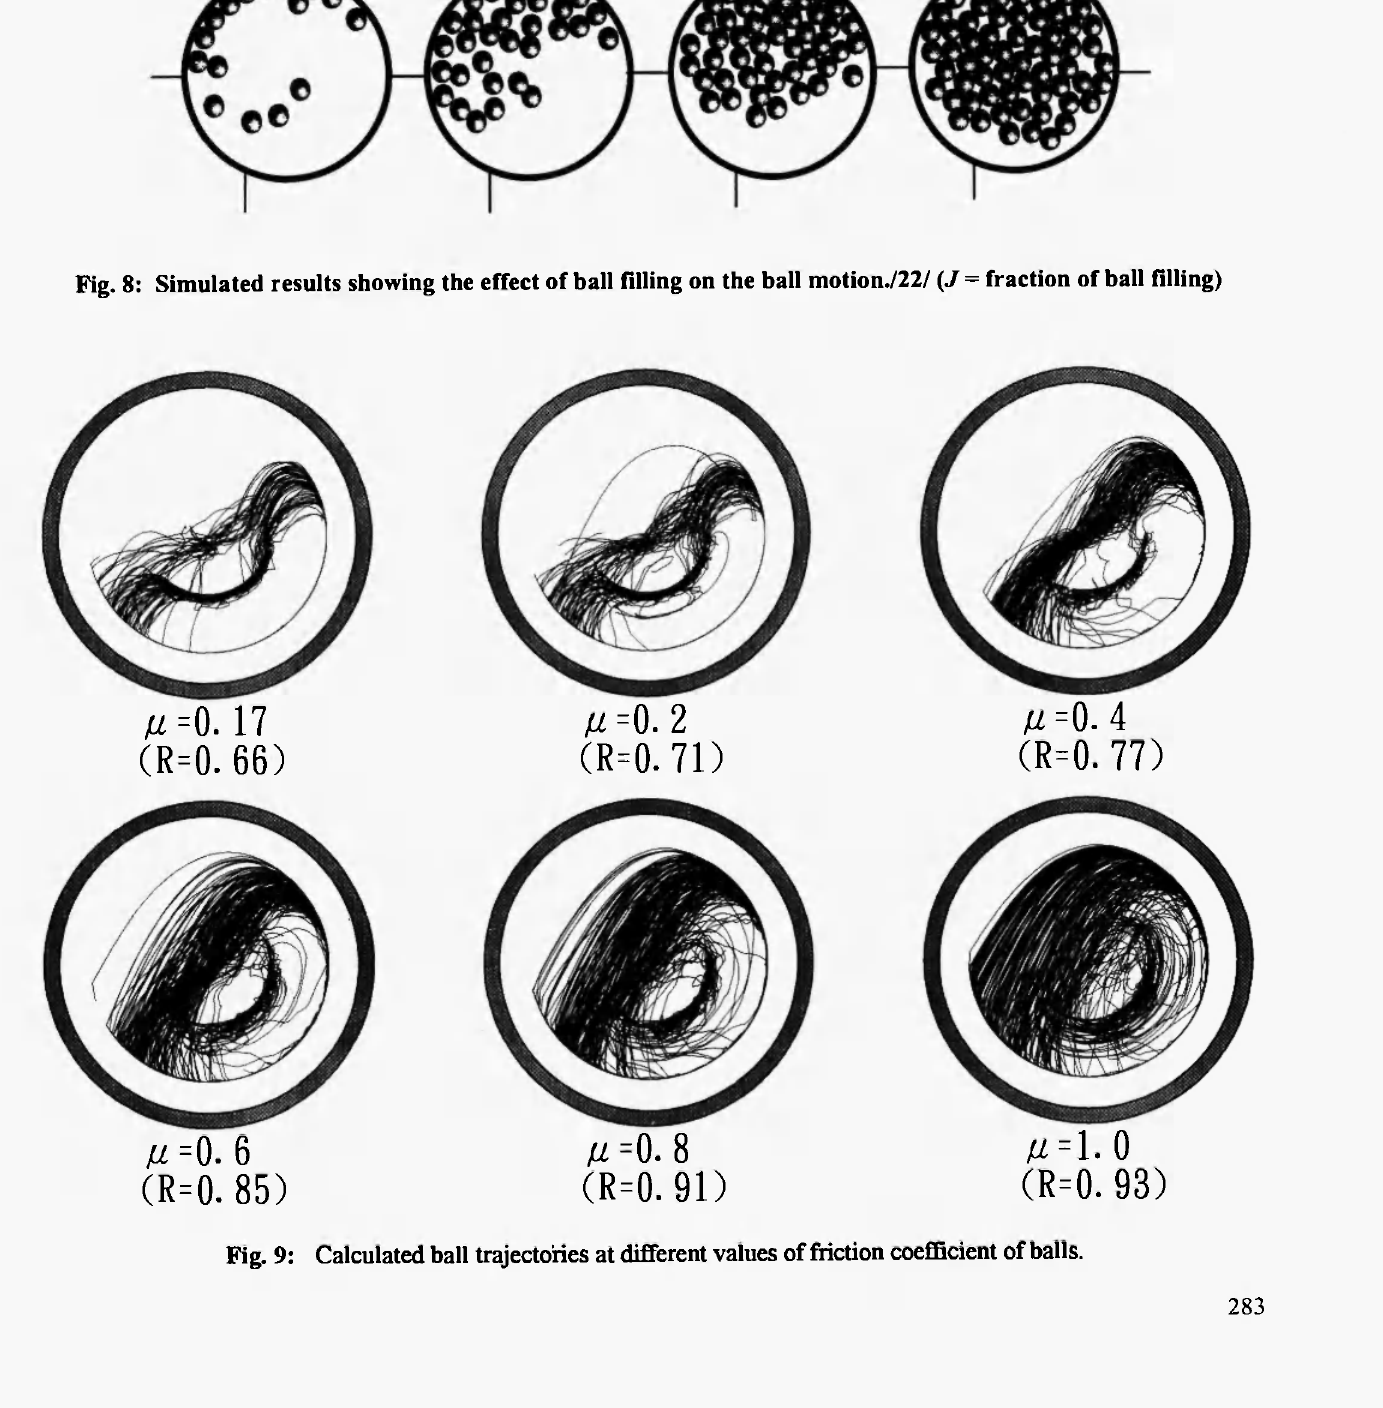
Fig. 8: Simulated results showing the effect of ball filling on the ball motion./22/ (7 = fraction of ball filling)